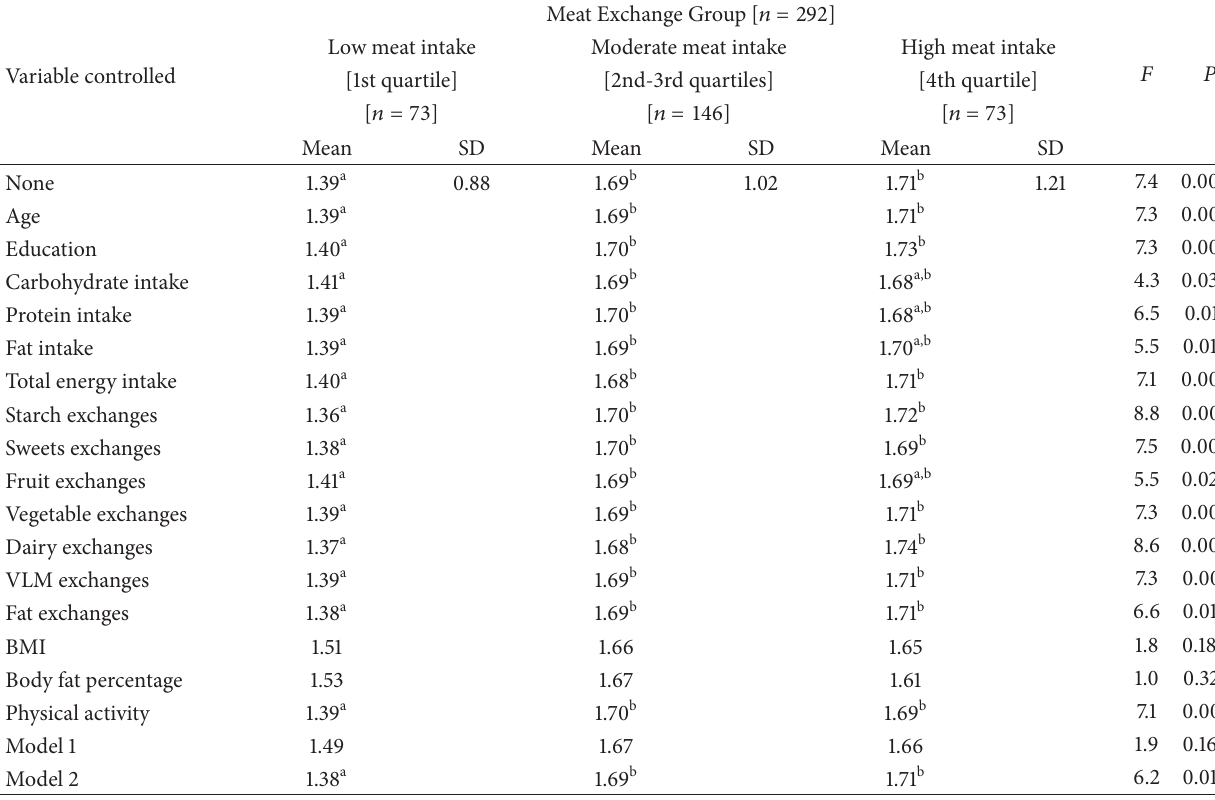
Table 2: Mean level of insulin resistance [HOMA] by meat exchange category, without and with means adjusted for potential confounders.